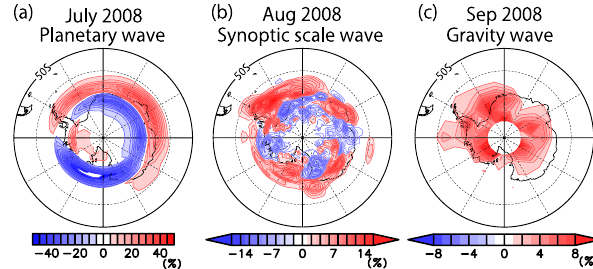
Fig. 13. Polar stereo projection maps of monthly-mean 1F (a) due to planetary waves at 16–20km in July, (b) due to synoptic-scale waves at 12km in August and (c) due to gravity waves at 15km in September.